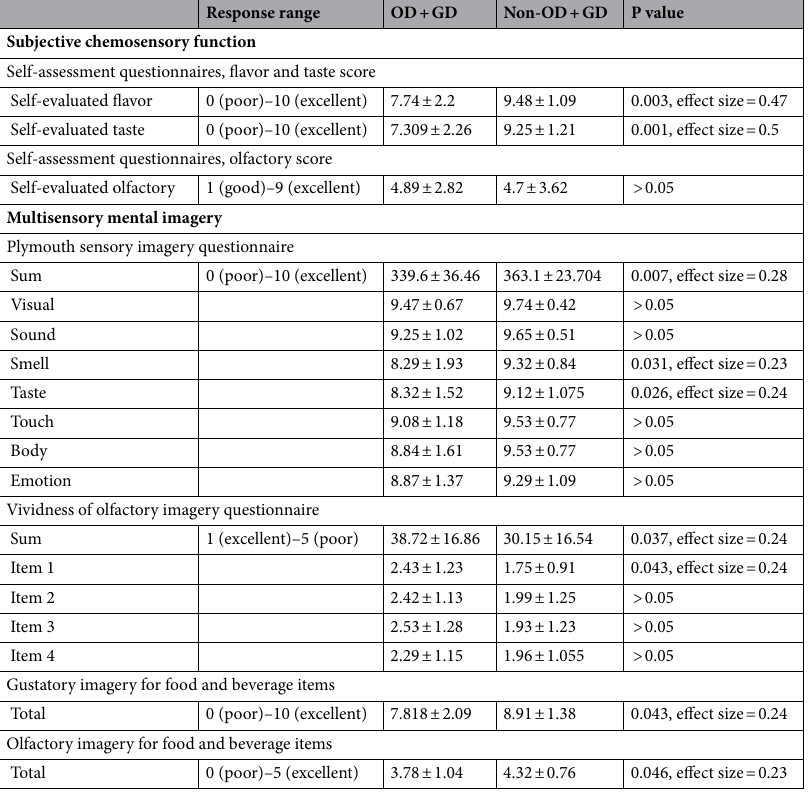
Table 4. COVID-19 patients’ performance according to whether they had olfactory and gustatory (OD + GD) dysfunctions or